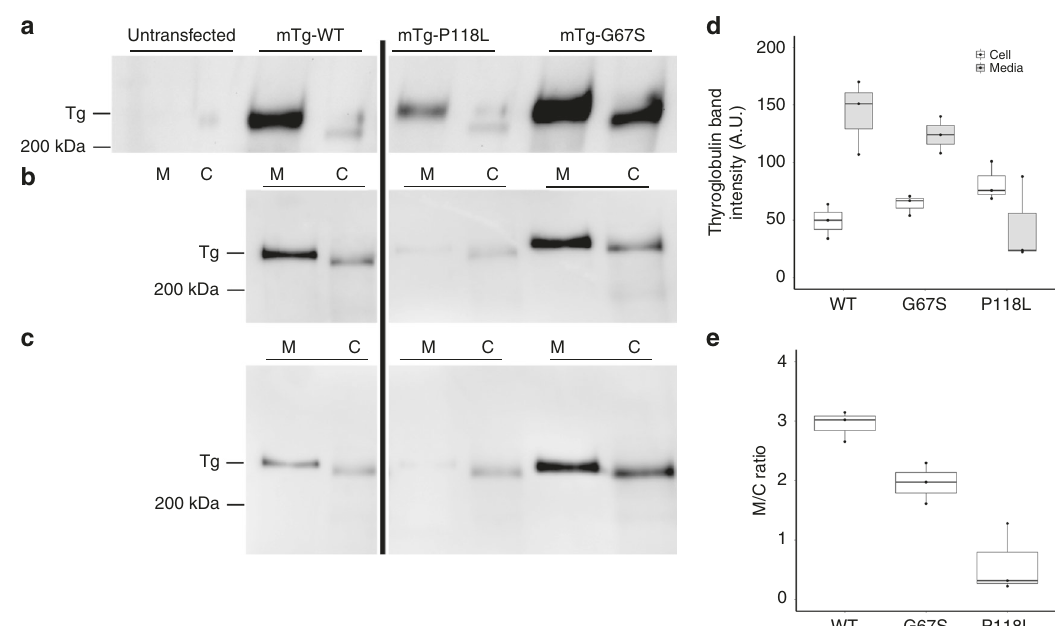
Fig. 1 Both the TG -P118L and TG -G67S point mutants exhibit a secretion defect. a – c Three independent replicate experiments. Western blotting of TG in 293T cells that were either untransfected ( a , no detectable bands) or transfected with constructs encoding mouse TG wild type (WT) or P118L or G67S point mutants (in the pcDNA3.1 background, in which the CMV promoter drives the respective cDNA expression). Serum-free media (M) were collected overnight and the cells (C) were lysed. Equal volumes of media and cells were analyzed by SDS-PAGE, electrotransfer to nitrocellulose, and immunoblotting with anti-Tg-speci fi c antibodies. Full scans of western blotting are presented in Supplementary Fig. 14. From scanning densitometry, d shows the content of thyroglobulin (and its variants) intracellularly and in the secretion. e The extracellular : intracellular (M/C) ratio of each construct. d , e Three independent replicate experiments. All boxplots in d and e indicate median (center line), 25th and 75th percentiles (bounds of box), and minimum and maximum